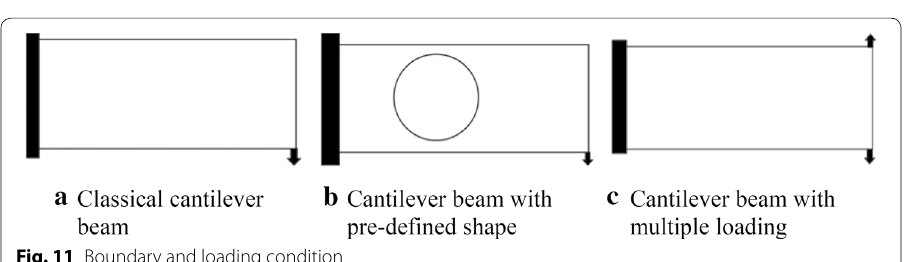
Fig. 10 Convergence history of hybrid method